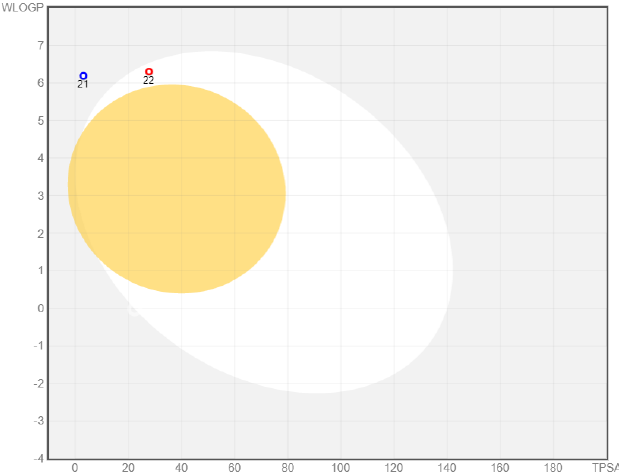
Figure 3. BOILED-Egg plot. Points located in the BOILED-Egg’s yolk (yellow) represent the molecules predicted to passively permeate through the blood-brain barrier, whereas the ones in the egg white are relative to the molecules predicted to be passively absorbed by the gastrointestinal tract; the blue dots ( 21 ) indicate the molecules for which it was expected to be effluated from the CNS by the P-glycoprotein, whereas the red ones ( 22 ) point to the molecules predicted not to be effluated from the CNS by the P-glycoprotein.